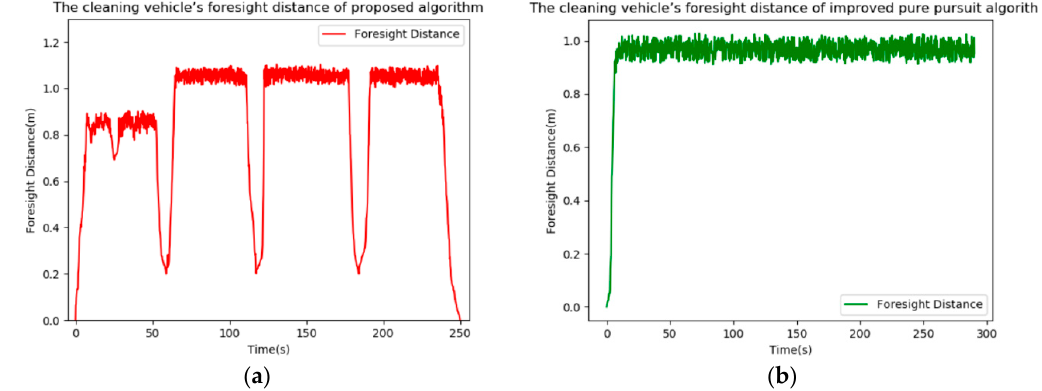
Figure 12. ( a ) The cleaning vehicle’s foresight distance under the proposed algorithm. ( b ) The cleaning vehicle’s foresight distance under the improved pure pursuit algorithm.